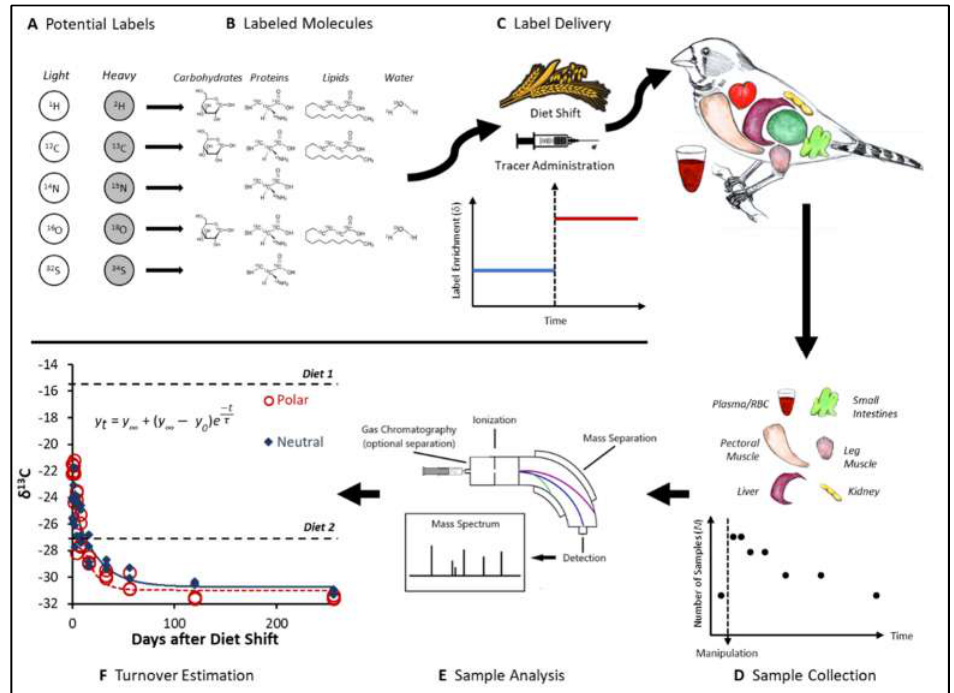
Figure 1. The process of estimating the turnover of tissues and specific compounds in animals using stable isotopes. Commonly used isotopic labels (A) include heavy isotopes of hydrogen, carbon, nitrogen, oxygen, and sulfur, which are then applied to different compounds of interest (B). The enrichment of the labeled compound(s) in animal tissues is then manipulated (C) with either a shift in diet or the administration of a dose of uniquely labeled molecules, and then tissue samples (D) are collected over time following the manipulation. Tissue sampling is typically concentrated in the period immediately following the manipulation, when changes in tissue isotope enrichment are most rapid. Isotopic enrichment of tissues is then measured by mass spectrometry (E), which separates isotopes by mass and may be preceded by a gas chromatography step to distinguish between compounds of similar class. Finally, the rate of change in isotopic enrichment is estimated (F), typically by fitting a first-order kinetic model to the data (formula shown). Models of turnover are illustrated with a comparison of the carbon turnover of neutral and polar lipids in zebra finch flight muscle from Carter et al. [26]. Please see the text for more details.